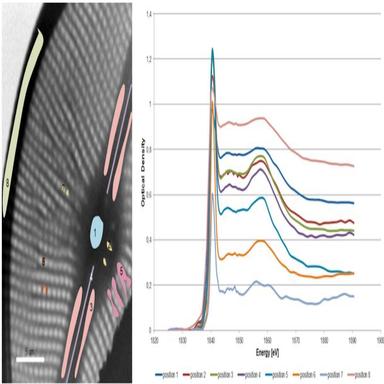
STXM image of the middle part of D. geminata frustule with the marked regions and corresponding plot of the optical density (OD) against the photon energy.